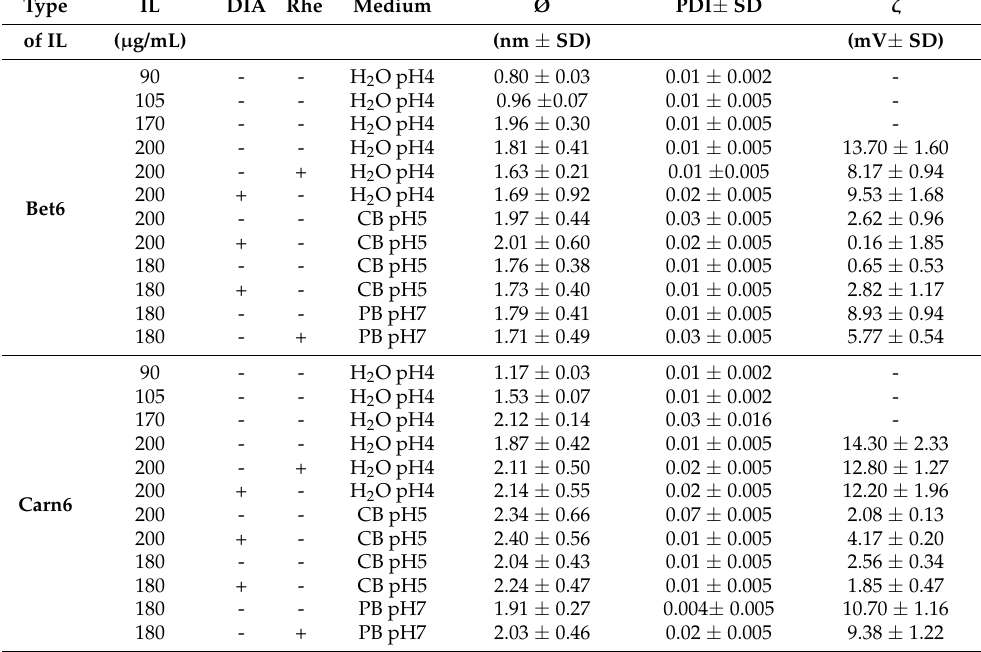
Table 1. Main physical features of IL-based nanoaggregates: Aggregates size distribution and zeta potential of IL-based aggregates. Effects of concentration, pH, and drug solubilisation. Rhe and DIA were at saturation solubility for Bet6 solutions corresponding to 220 µ g/mL and 1.350 mg/mL, respectively, and for Carn6 solutions corresponding to 130 µ g/mL and 680 µ g/mL, respectively. Type IL DIA Rhe Medium Ø PDI ± SD ζ of